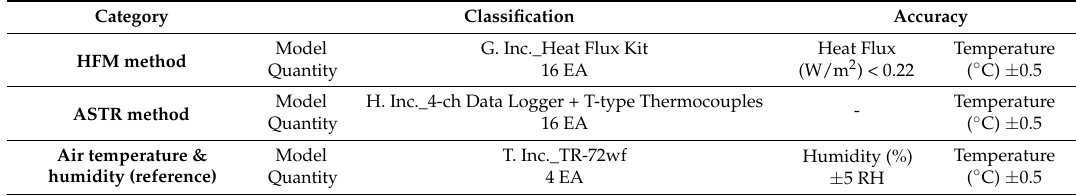
Table 3. Overview of measurement equipment.